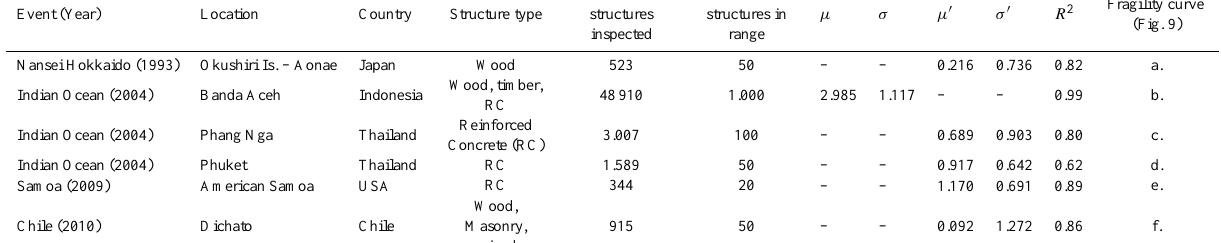
Fragility curve (Fig. 9)